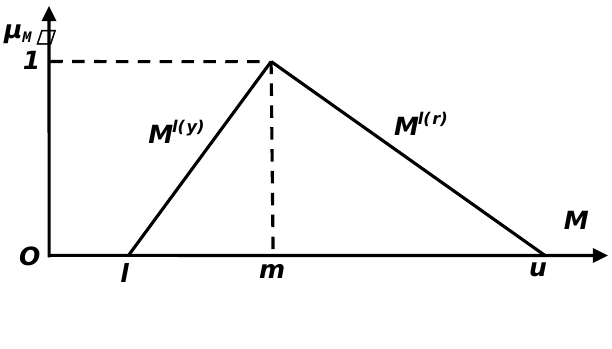
Figure 1. “Triangular fuzzy number M 